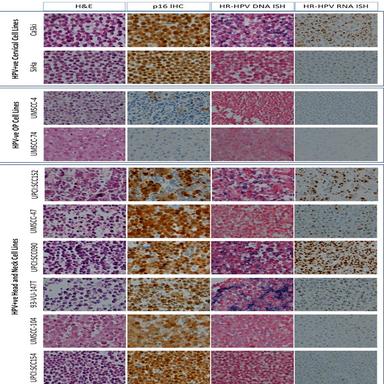
H&E staining, p16 IHC, HR-HPV DNA ISH and HR-HPV RNA ISH results. p16 IHC positive: brown stain; HR-HPV DNA ISH positive: blue stain; HR-HPV RNA ISH positive: brown stain.